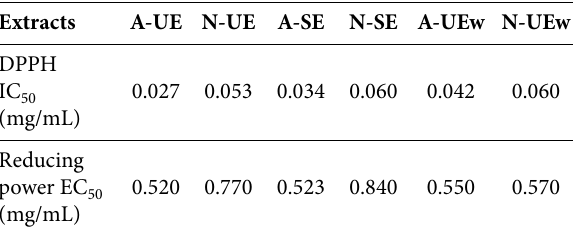
Table 3. Antioxidative activity of chamomile extracts obtained by a different extraction technique